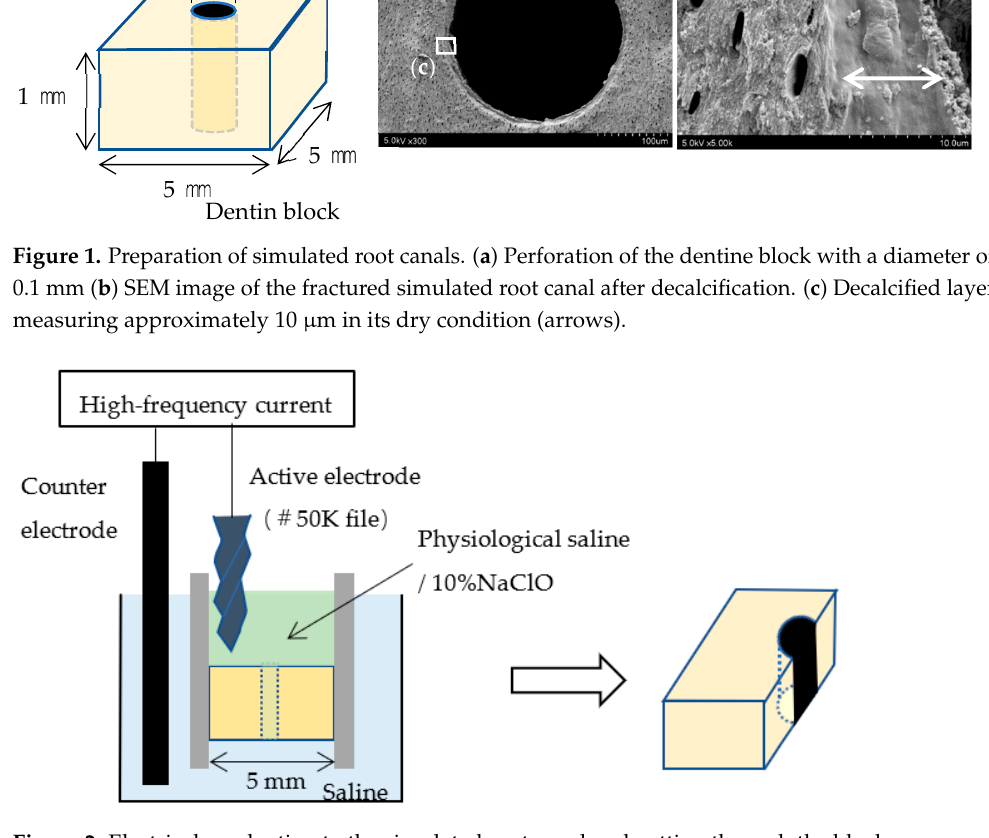
Figure 2. Electrical conduction to the simulated root canal and cutting through the block. Table 1. Energy conditions for each group ( n = 6 in each group).